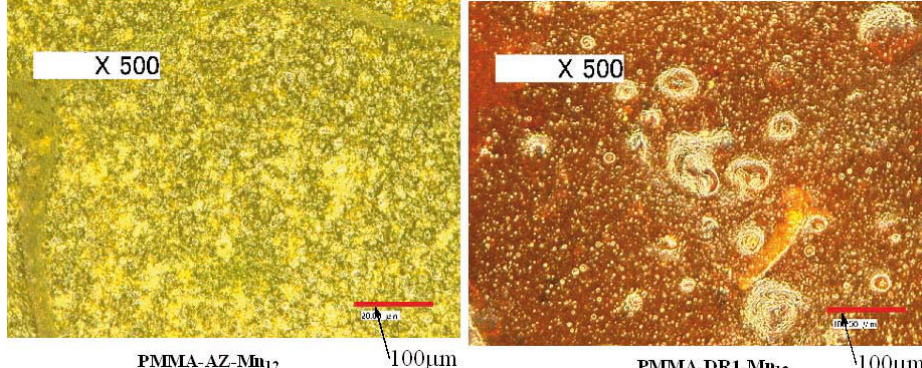
Figure 2. PMMA-AZ-Mn